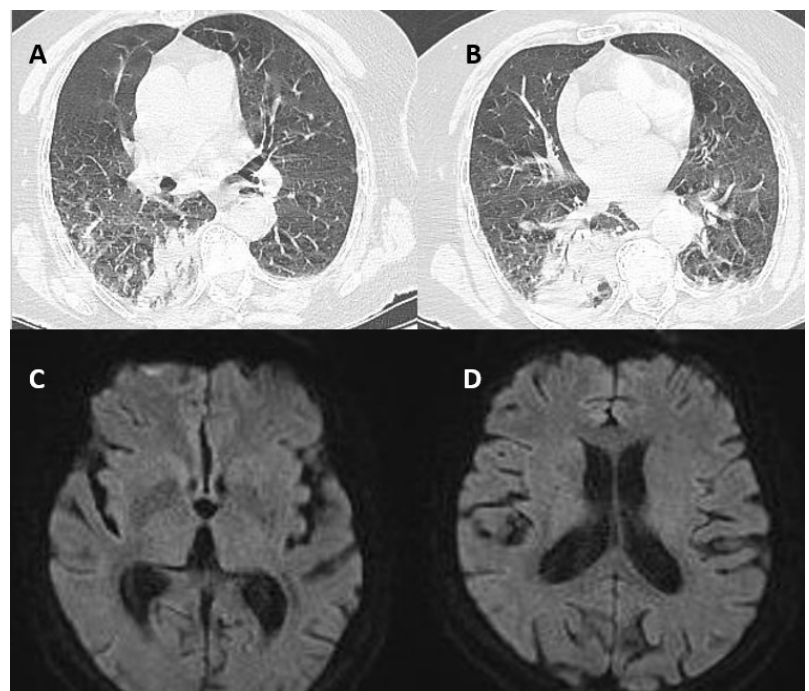
Table 1. Creatine Kinase values during hospitalization compared to grade of rigidity.